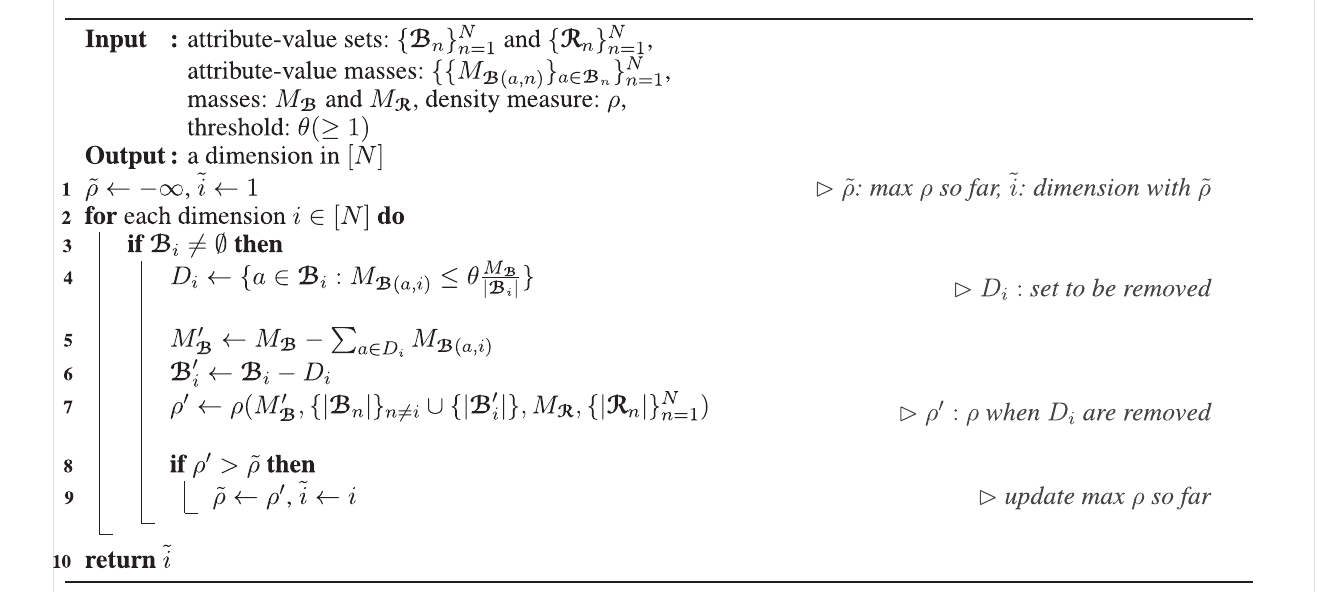
Algorithm 4 | select _ dimension by